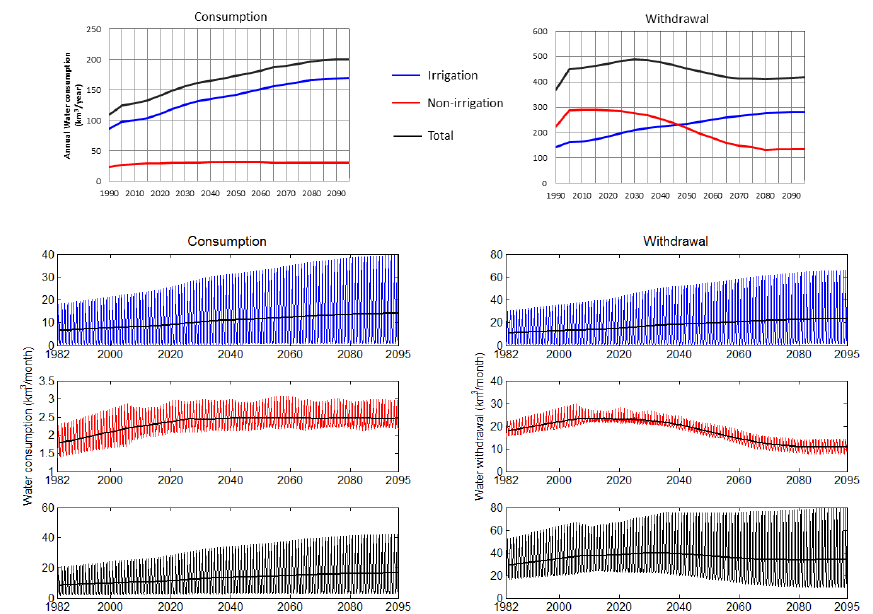
Figure 6b: (a) Annual water demand by sector from GCAM for the time period of 1990-2095 under A2 scenario. (b) 2 Fig. 5b. (a) Annual water demand by sector from GCAM for the time period 1990–2095 under A2 scenario. (b) Monthly downscaled water Monthly downscaled water demand by sector for the time period of 1982-2095 under B2 scenario. 3 demand by sector for the time period 1982–2095 under B2